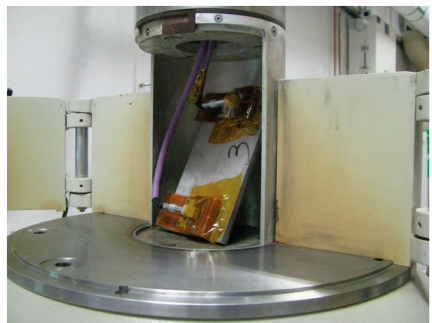
Figure 9. Gamma radiation test setup in the gamma cell where the transmitter and the receiver are separately attached to both ends of a 6.35 mm thick 304 stainless steel plate, and employ the through-transmission